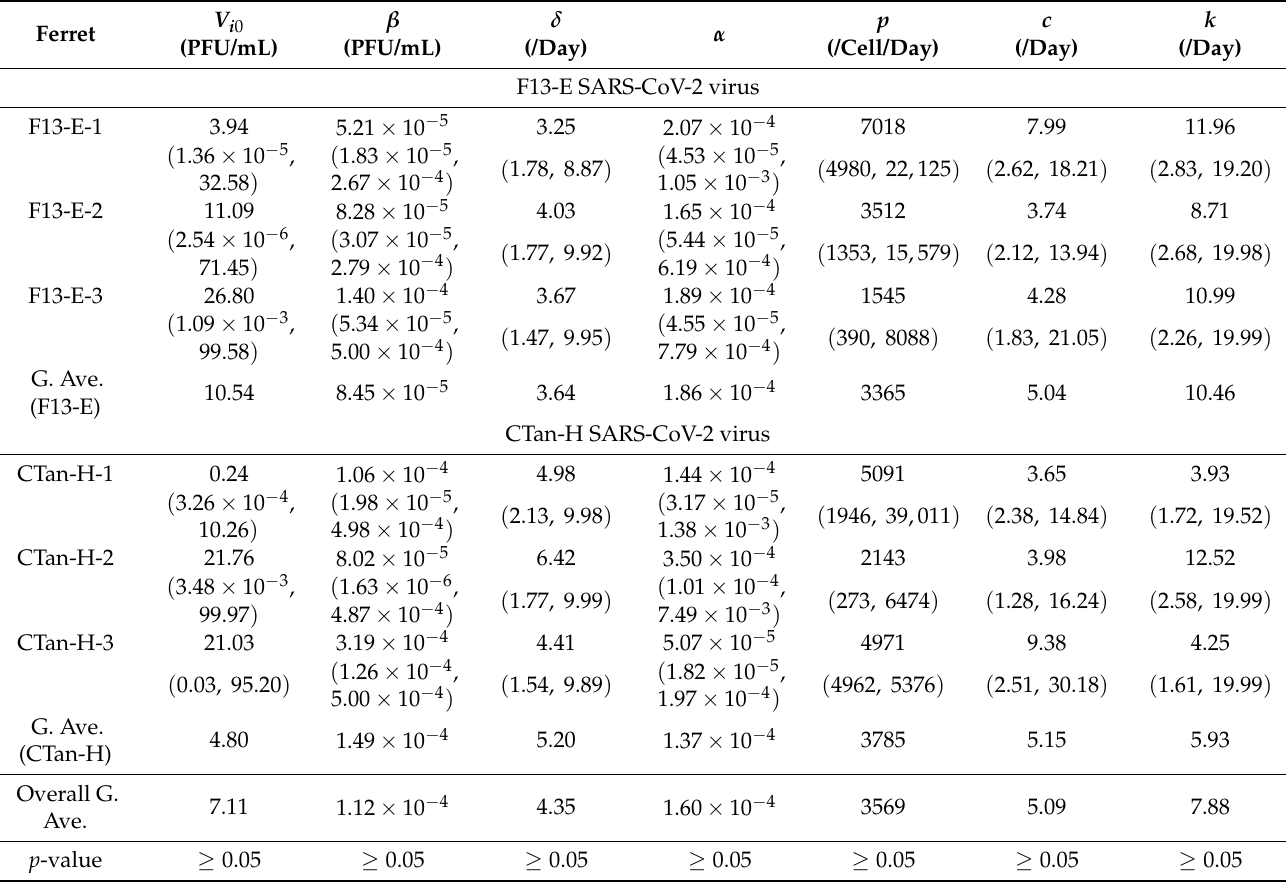
Table 2. Parameters of Model 2 estimated from the data fitting. G. Ave. stands for geometric average. p -values indicate the result of comparison between F13-E and CTan-H groups.